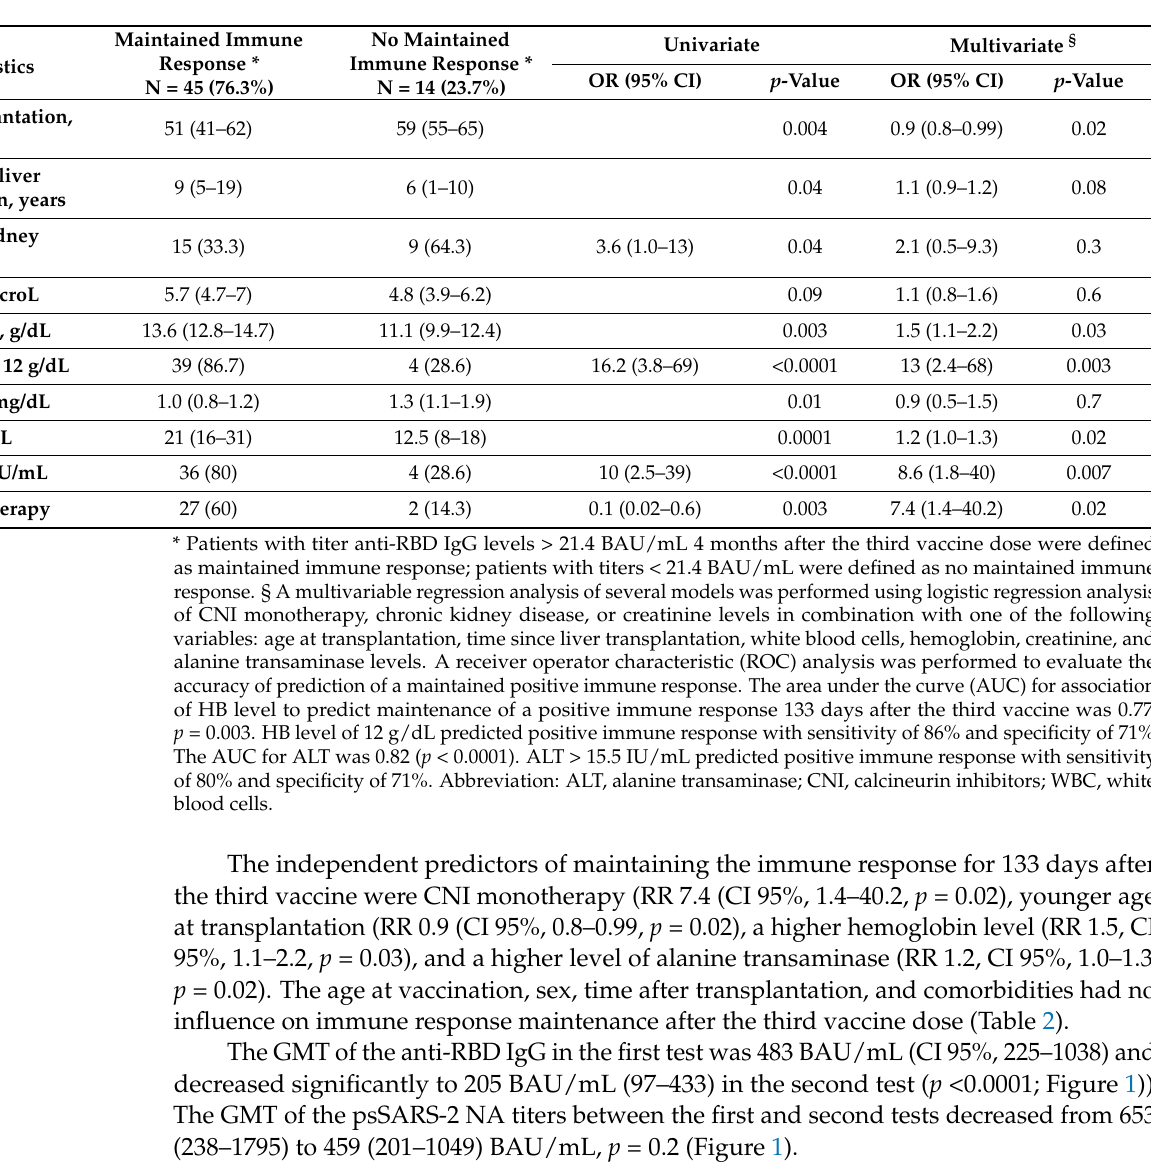
Table 3. Predictors of a maintained positive immune response 133 days after the third BNT162b2 vaccine